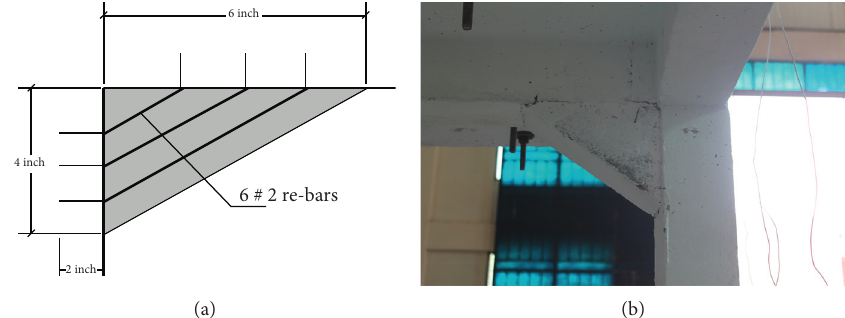
Figure 3: Geometric and reinforcement details of RC haunches for 1: 3 reduced scale models. (a) Details of RC haunch (1:3 scale). (b) Pictorial view of the model